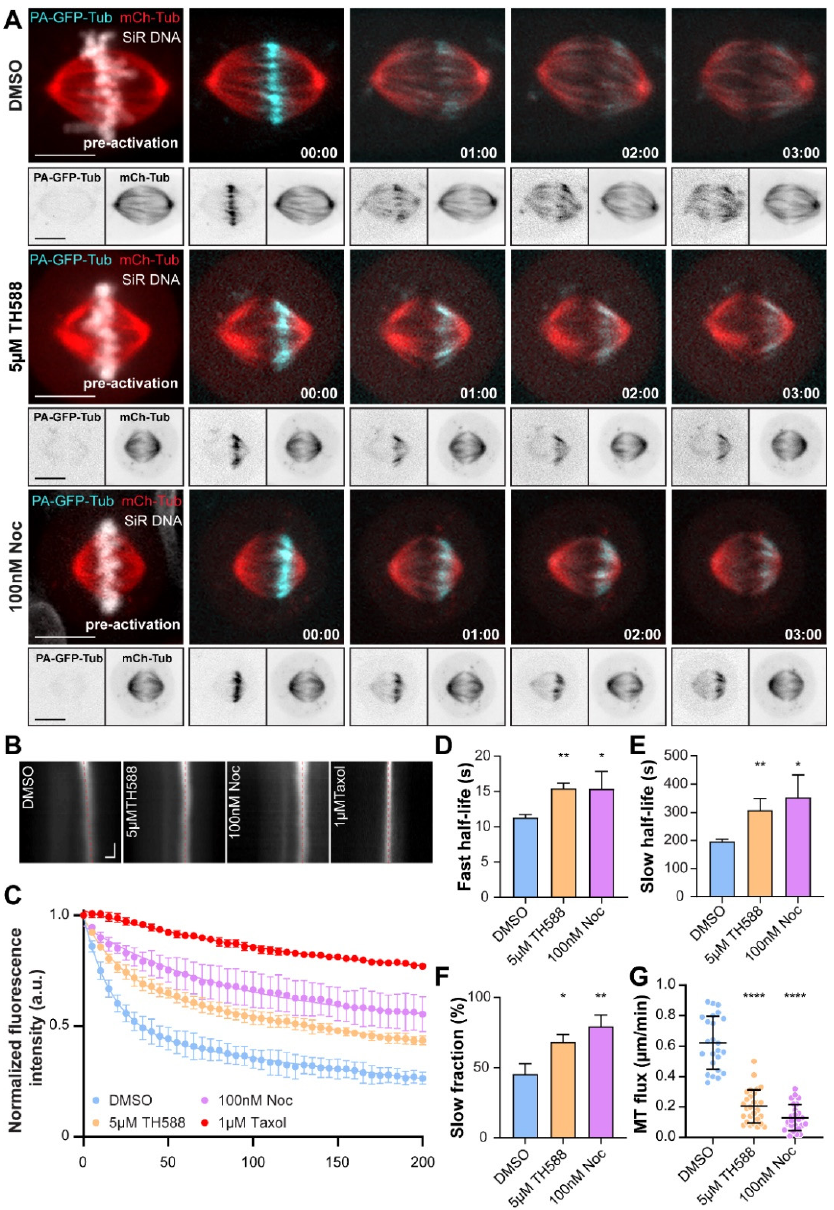
Figure 4. TH588 and low concentration of nocodazole similarly reduce MT turnover within the mitotic spindle. ( A ) Representative spinning-disk confocal time-lapse images showing MT turnover in U2OS-PA-GFP/mCherry α -tubulin cells undergoing indicated treatments. Metaphase-arrested one half-spindle MTs were photoactivated and tracked over time. DNA counterstained using SiR-DNA is shown in white in the first merged image of the time series while photoactivated MTs are in cyan and mCherry- α -tubulin in red. Bottom panels show inverted individual channels of PA-GFP and mCherry- α -tubulin channels. Scale bar 10 µm. Time, min:s. ( B ) Representative sum-projected ky- mograph profiles of photoactivated MTs in metaphase-arrested mitotic spindles of U2OS-PA- GFP/m-cherry α -tubulin cells undergoing indicated treatments (red dashed lines highlight the pres- ence or absence of MT poleward flux). Scale bars, 2 µm (horizontal) and 30 s (vertical). ( C ) Expo- nential decay of normalized, photobleaching corrected fluorescence intensity of photoactivated α - tubulin over time. Data represent mean ± SEM from three independent experiments (n = 25 cells for DMSO, 31 cells for 5 µM TH588, and 22 cells for 100 nM nocodazole). Total of 1 µM taxol treatment profile serves as a control for bleaching-correction. ( D – F ) Fast and slow half-lives representing non-